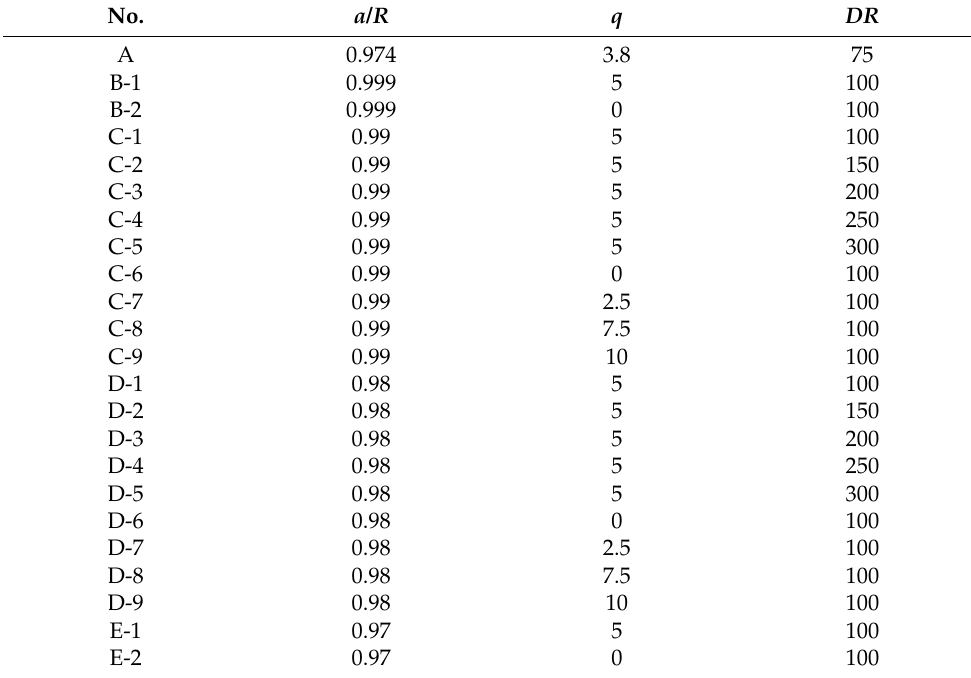
Figure 2. The element mesh of FIPP and steel pipe model. Table 2. Geometric parameters of the numerical model.